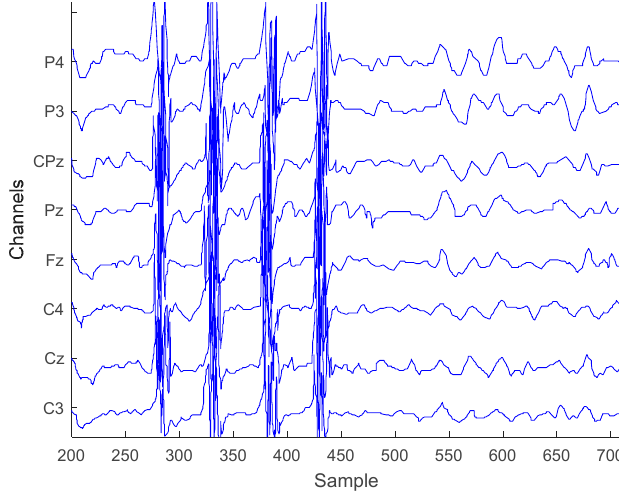
Figure 7. Teeth clenching and eye-blink test EEG signals.